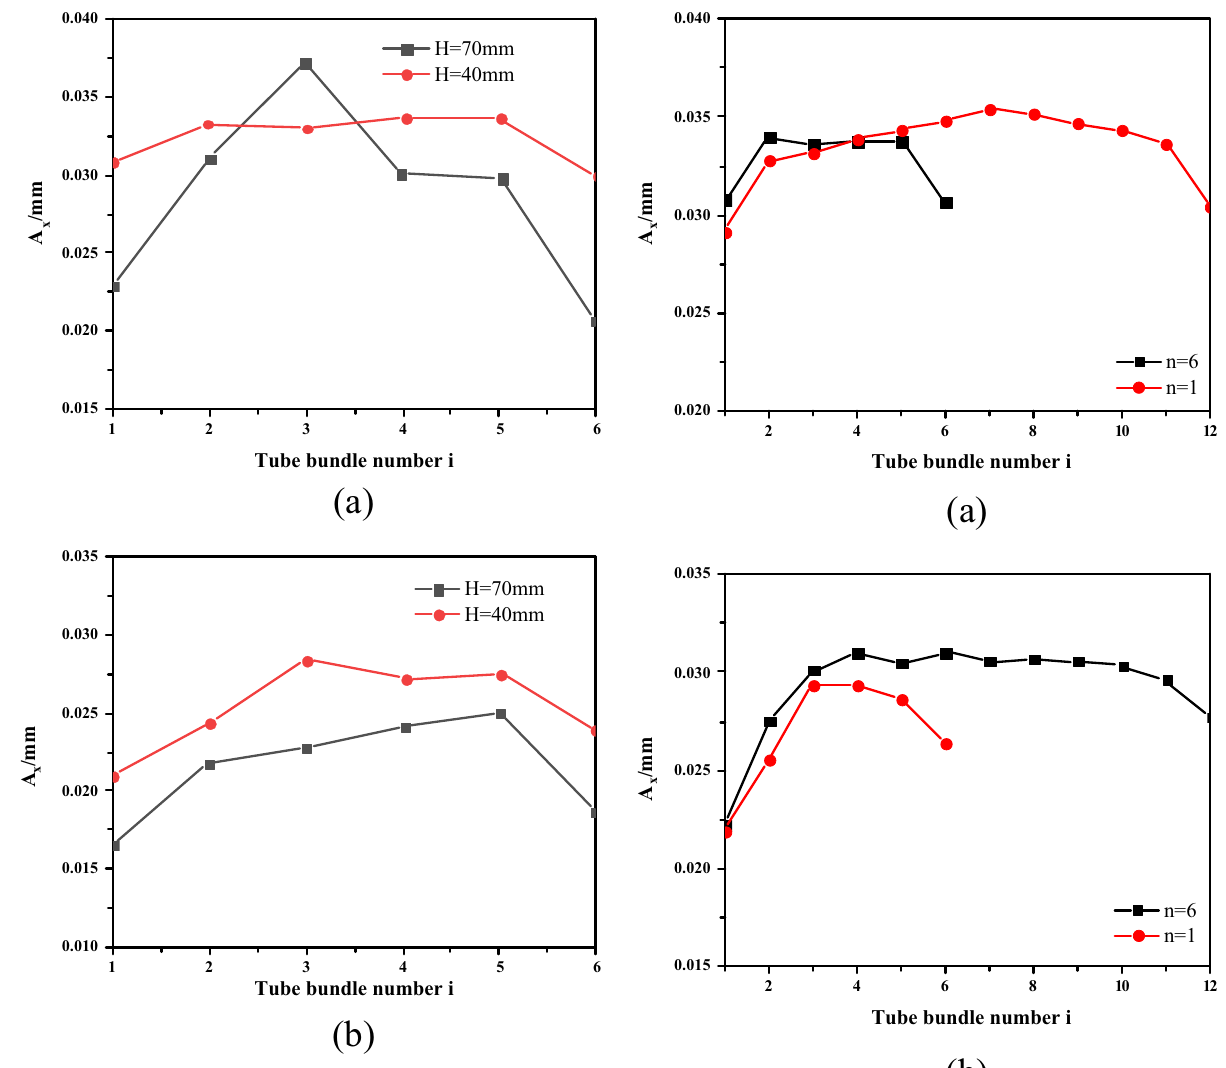
Figure 3: Variation of monitoring point amplitude with tube bundle number at di ff erent tube row spacing. ( a ) Stainless steel connector III. ( b ) Stainless steel connector IV.